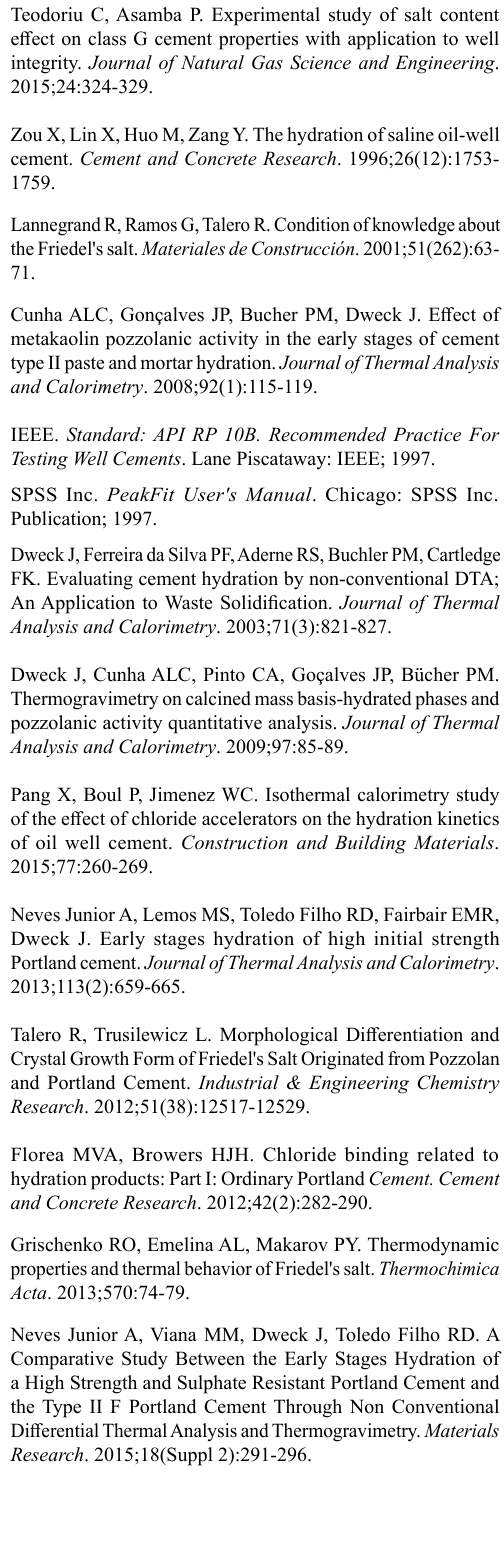
); AFt (ettringite); F (C 2